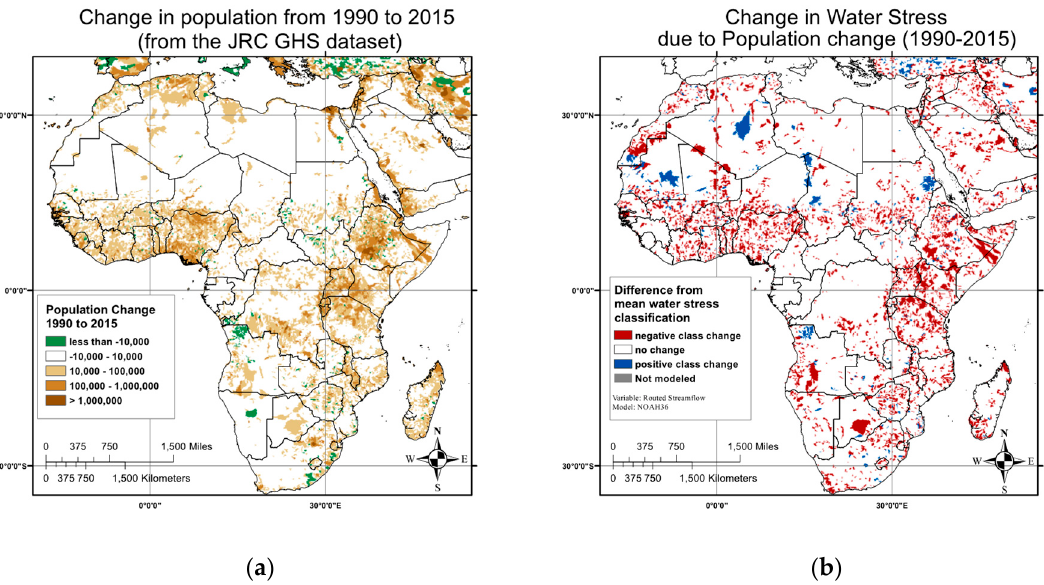
Figure 5. ( a ) Change in population between 1990–2002 and 2003–2015 from the JRC Global Human Settlement (GHS) dataset. Population is largely increasing, some places more than others. Ethiopia, Nigeria and Lake Victoria basins are notable; ( b ) using average streamflow conditions the effect of population has been to increase water scarcity. Change in classification due to population change is almost exclusively negative (i.e.,